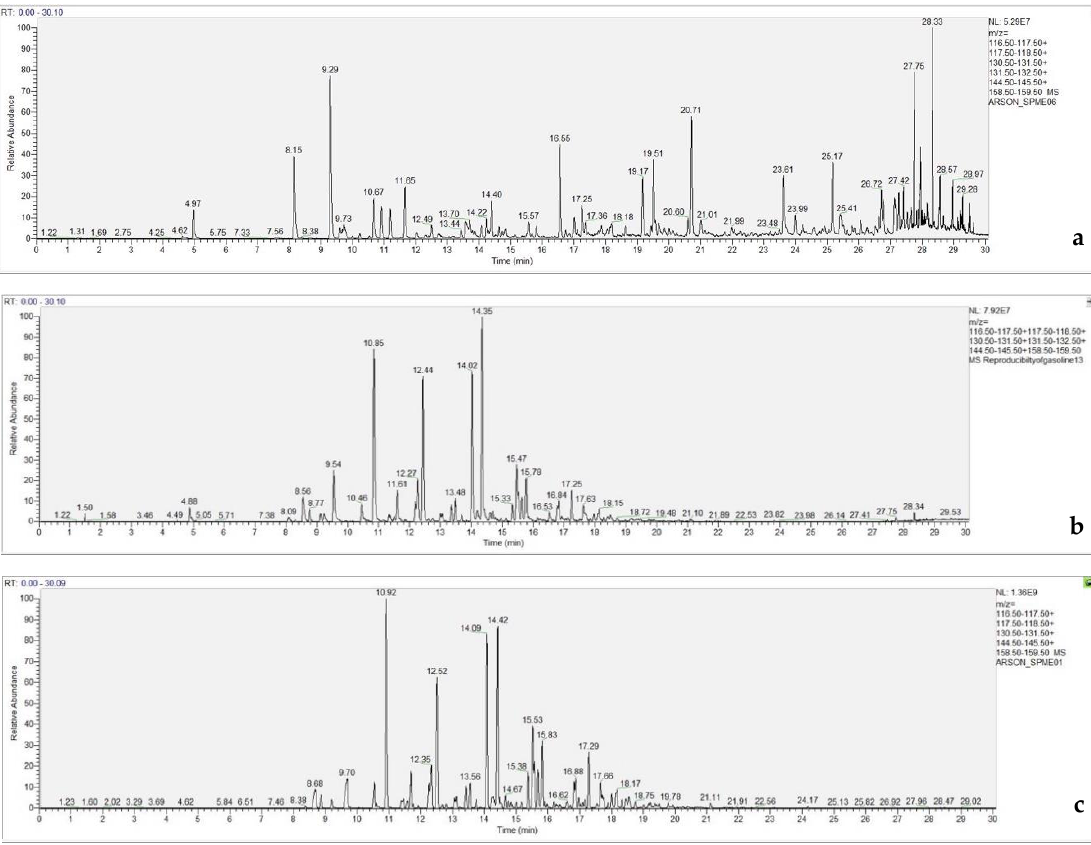
Figure 6. Extracted indane profiles of ( a ) carpet #1 burned without ILs; ( b ) carpet #1 burned with gasoline; and ( c ) neat gasoline.